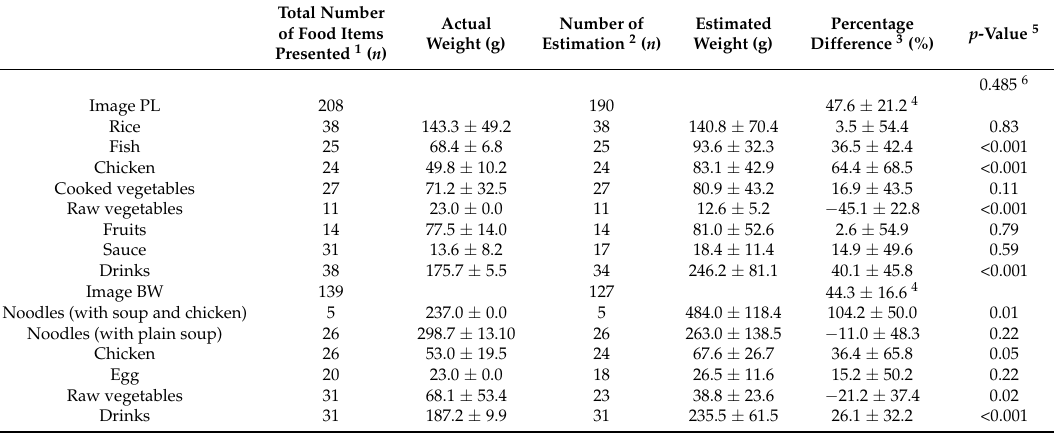
Table 4. Accuracy of portion size estimation by number of estimation for Image PL ( n = 38) and Image BW ( n =